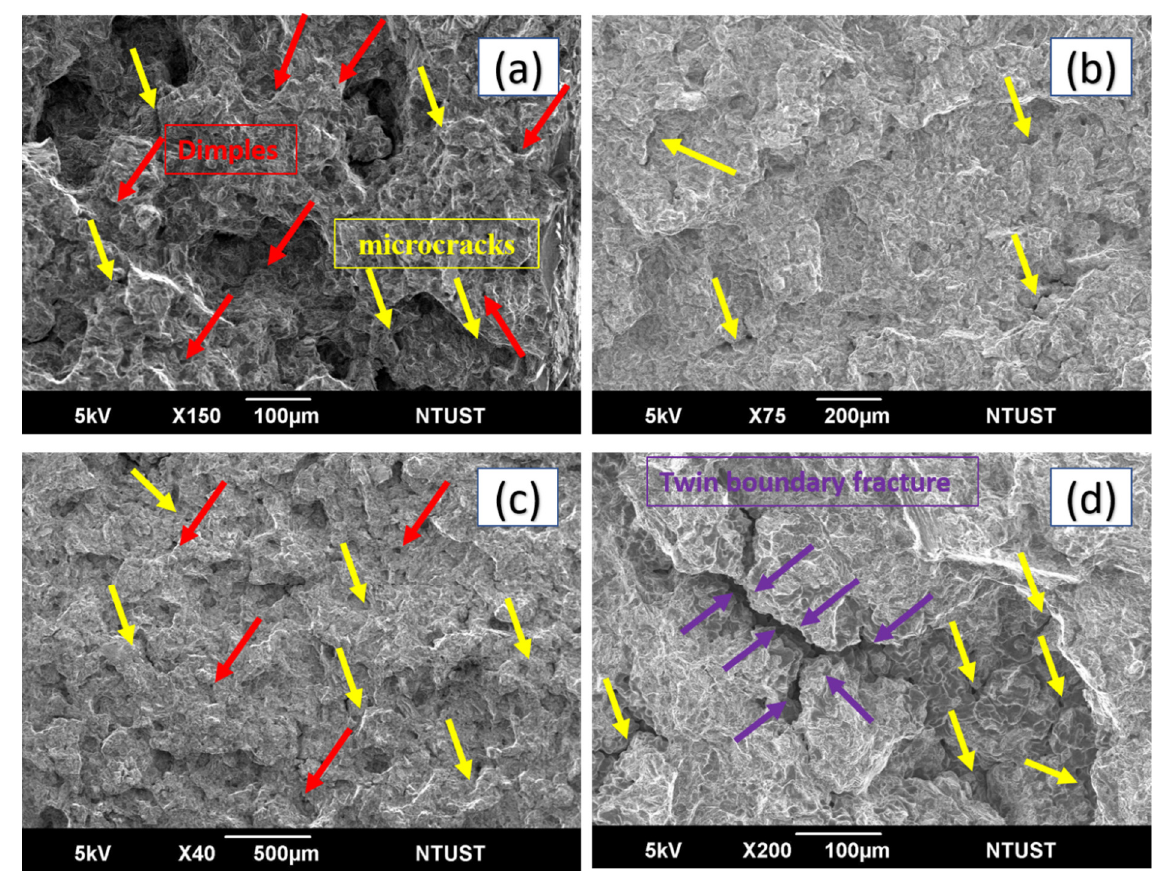
Figure 15. Fractography of the impact-ruptured surfaces of ( a ) pure AZ91 matrix, ( b ) AZ91 + 0.5 wt.% SiCp, ( c ) AZ91 + 1 wt.% SiCp and ( d ) AZ91 + 0.5 wt.% SiCp + 1 wt.% Bi + 0.4 wt.% Sb.